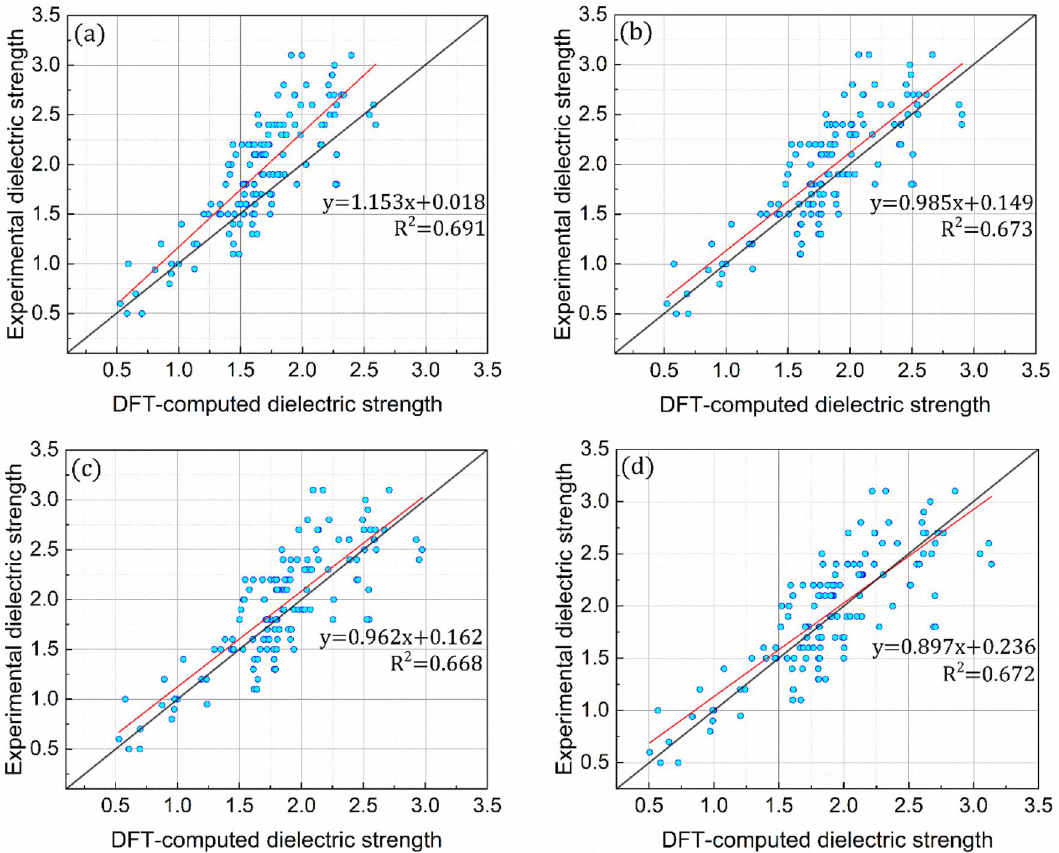
Figure 8. Introduction of a new variable to computational protocol for dielectric strength. Comparisons between the equation-predicted and experimental dielectric strengths for all the organic compounds in Fig. S3 in the Supporting Information. The coefficients of the equations are parameterized for the equation-based prediction of the experimental values of either ( a ) 30, ( b ) 60, ( c ) 90 selected randomly among the organic compounds in Fig. S3 in the Supporting Information, or ( d ) all the compounds. The equations are correlated with polarizability, ionization energy, and molecular